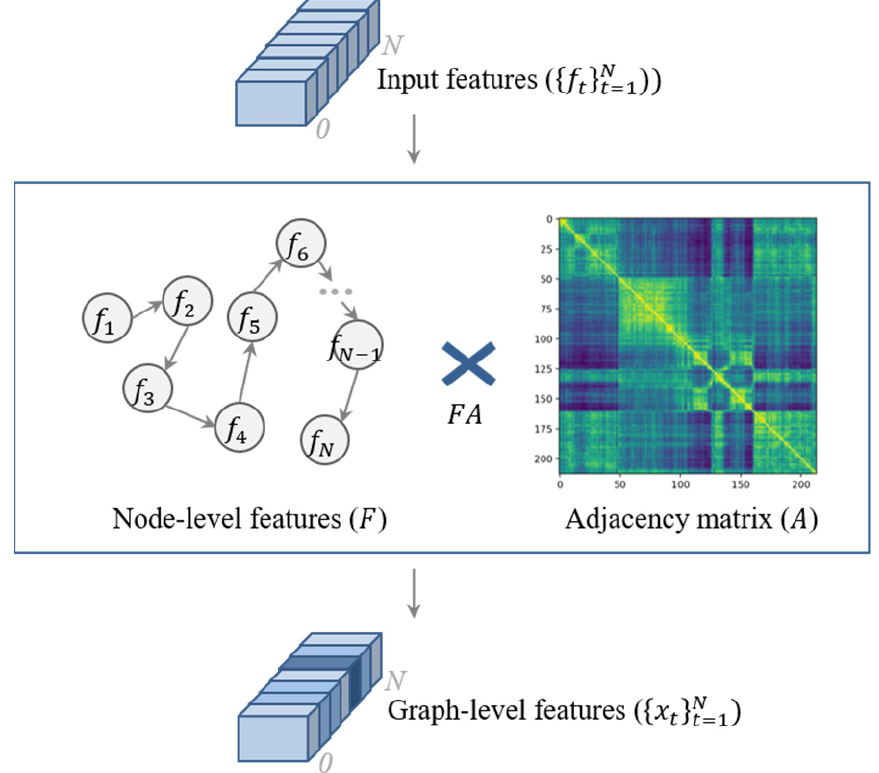
Figure 3. Convert the input features to the graph-level features.